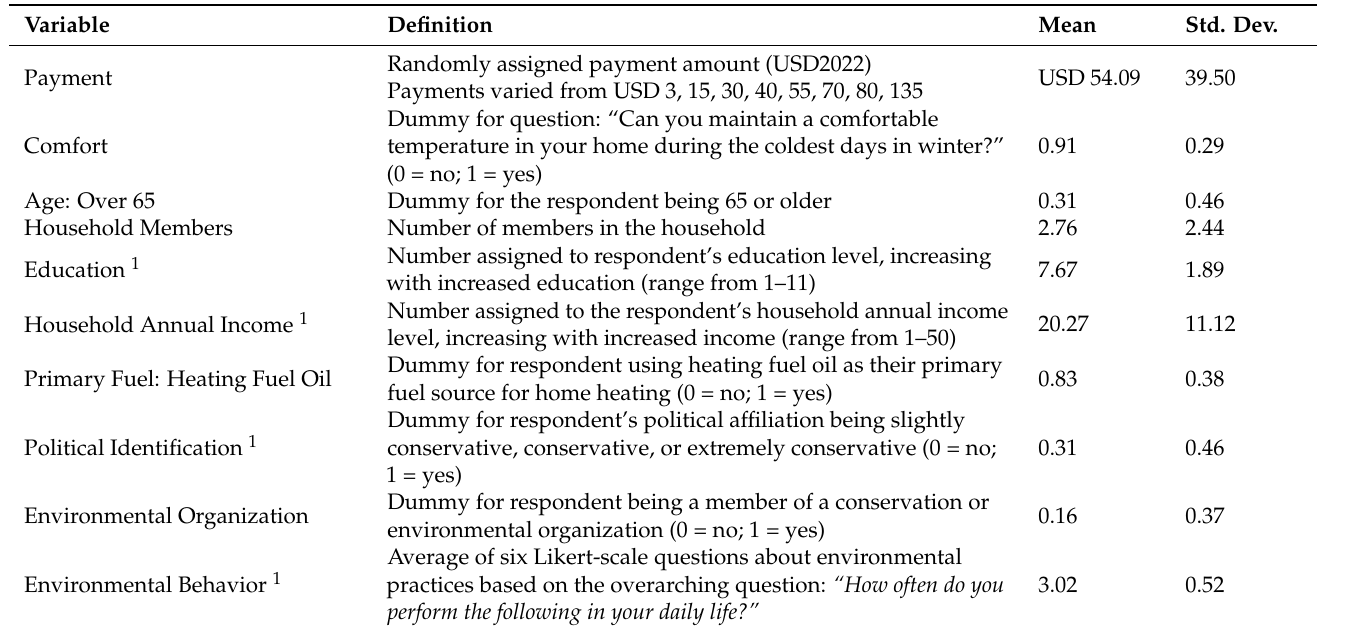
Table 4. Definitions and Summary Statistics of